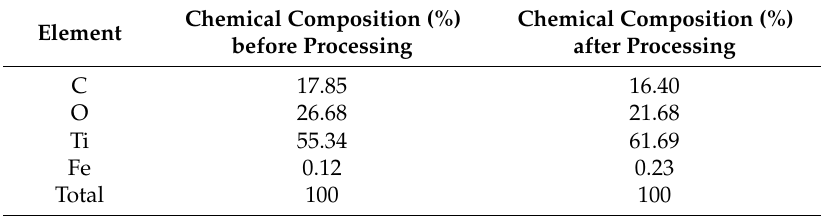
Figure 11. EDS chemical composition mapping of before and after processing the workpiece: ( a ) before finishing Ra = 0.32 and ( b ) after finishing Ra = 0.08. Table 4. Chemical composition of β -titanium wire before and after finishing.